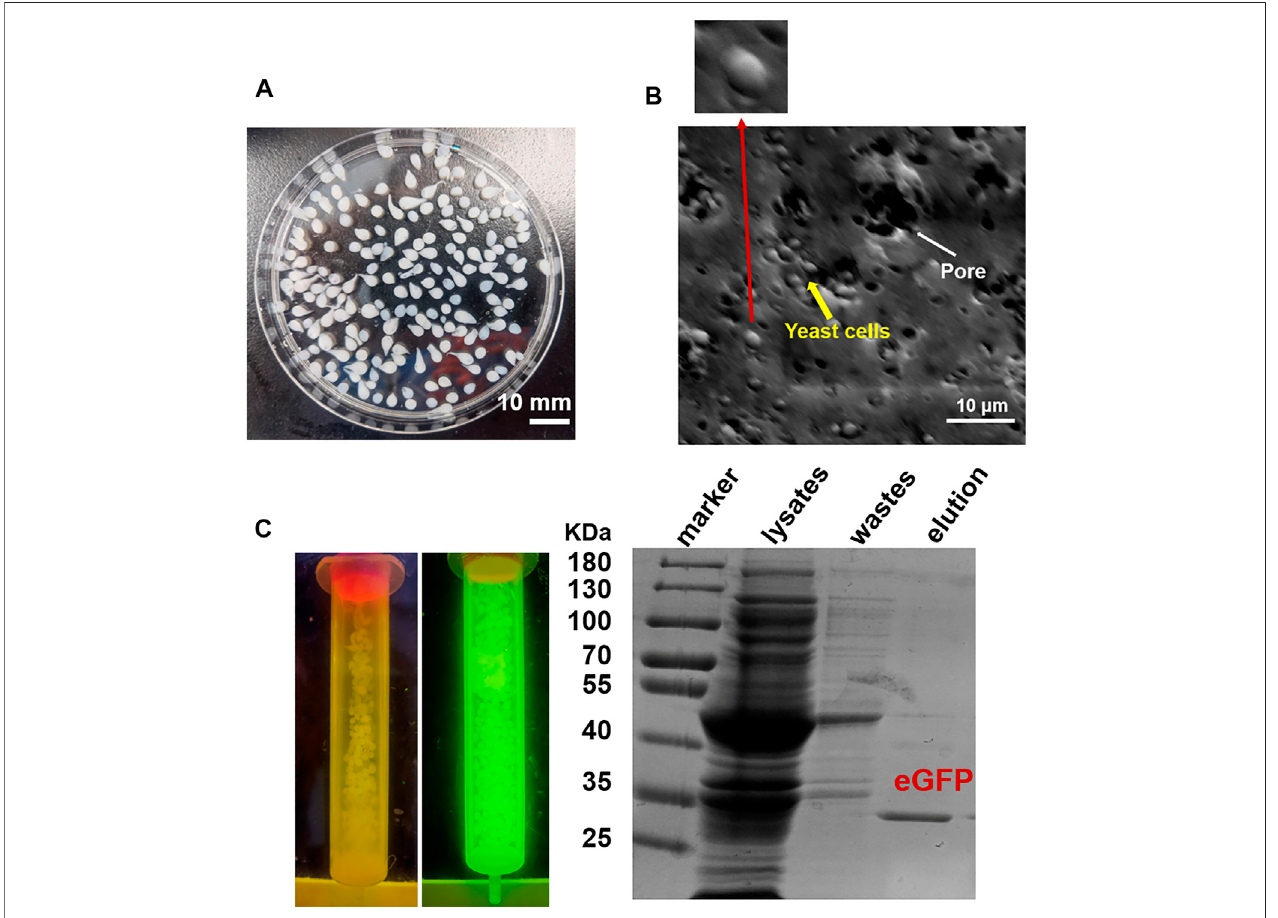
FIGURE 2 | (A) Image of SA@yeast beads. (B) Scanning electron microscopy (SEM) image of SA@yeast beads after air-blast drying. The inset shows a magni fi cation of one yeast cell. (C) Puri fi cation of eGFP by using SA@yeast beads. (Left) Blue light transmitter analysis of SA@yeast beads without or with CL7-eGFP. (Right) 10% SDS-PAGE analysis of E. coli cell lysates, washing wastes, and eluted eGFP.